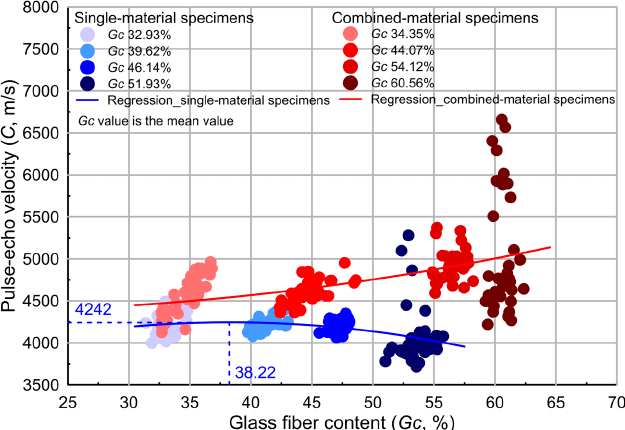
Figure 7. Variation of pulse-echo velocity with G c .